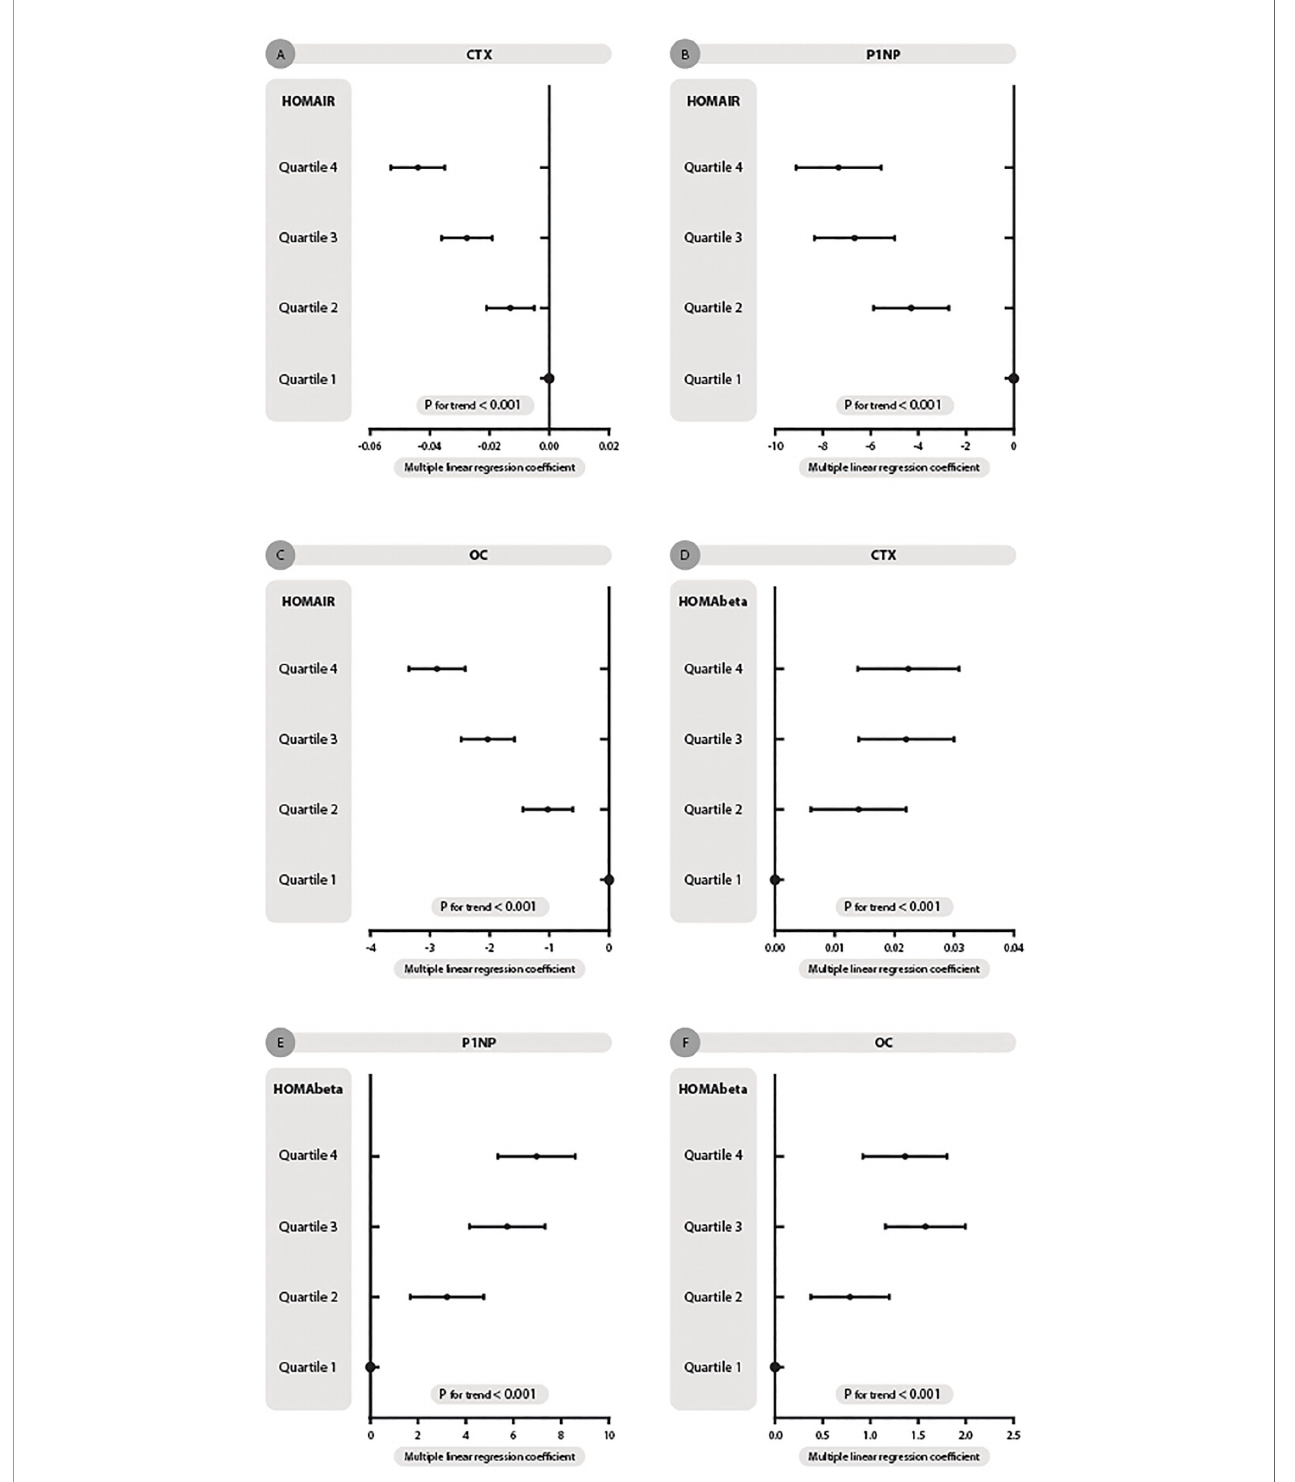
FIGURE 2 | HOMA-IR and HOMA-beta quartiles with changes in the association of b -CTX, P1NP and OC concentration in dysglycemia patients. (A – C) represent HOMA-IR quartiles with b -CTX, P1NP and OC concentration trends, respectively. (D – F) represent HOMA-beta quartiles with three turnovers mentioned. Multiple linear regression coef fi cients were adjusted for sex, age, BMI, lipids, Vit D, C-peptide, current smoking and drinking, hypertension, CVD, dyslipidemia and drug